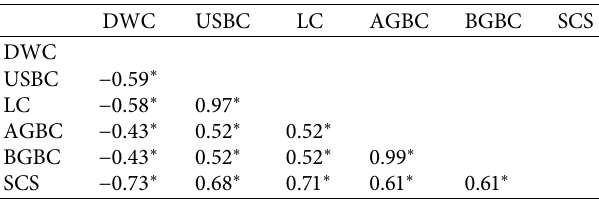
Table 6: Pearson’s product moment correlation coefficient and P value between carbon pools in Anshirava